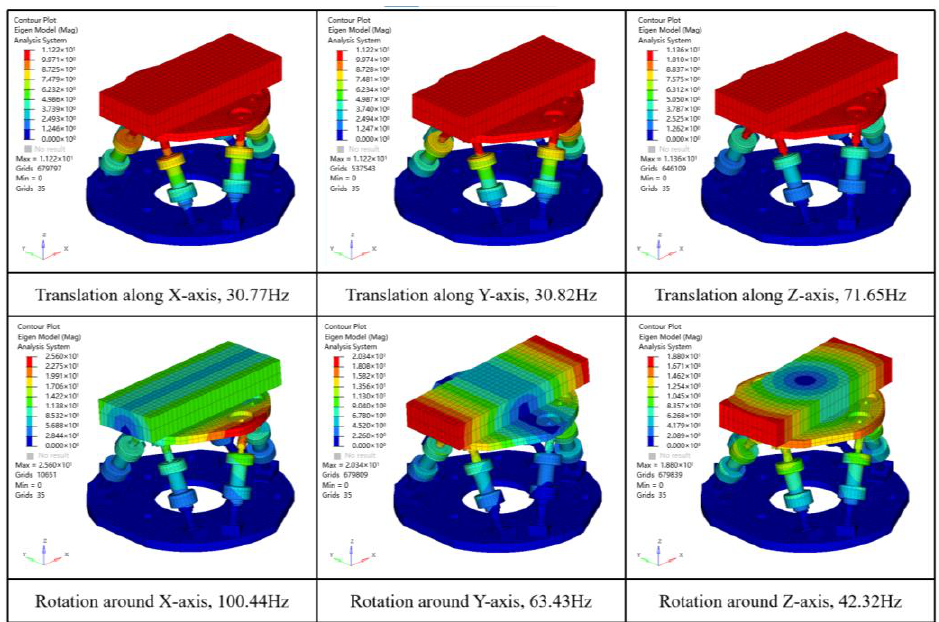
Figure 3. Modal analysis results of Stewart platform with flexible joints.